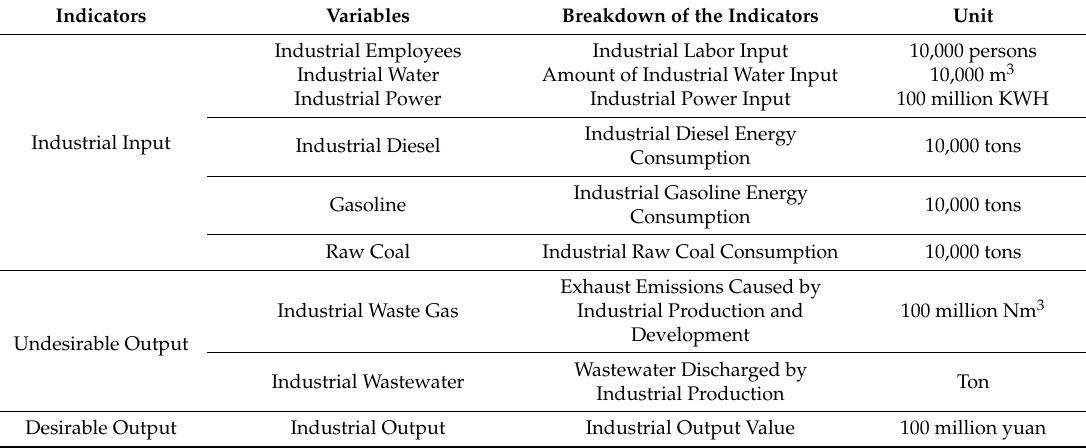
Table 1. Measurement Indicator System of the Eco-e ffi ciency of Industrial Energy in the Yangtze River Economic